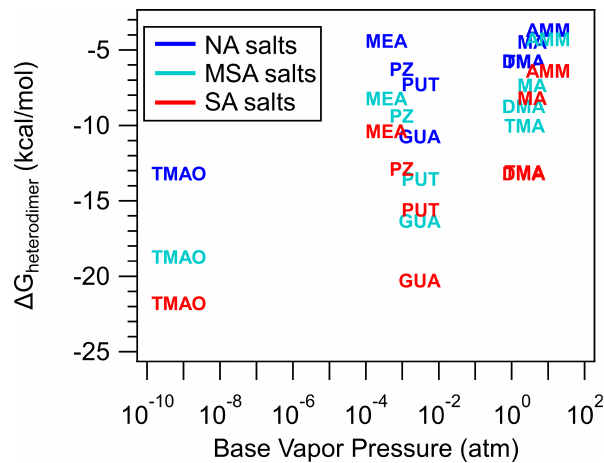
Figure 7. Base vapor pressure plotted against (cid:49)G heterodimer for SA, MSA and NA